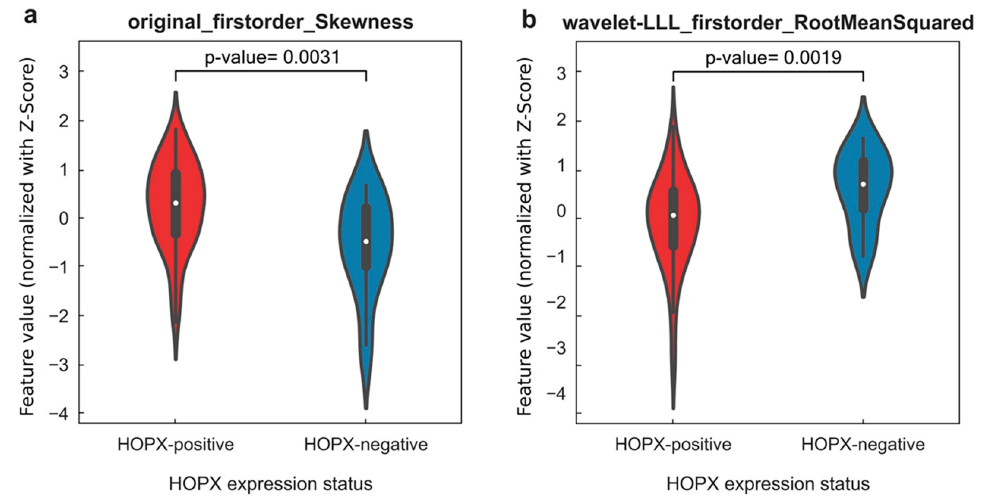
Figure 7. ( a ) Violin plot of image feature “original_firstorder_Skewness” of all HOPX-positive and HOPX-negative patients, which showed a significant difference in data distribution ( p = 0.0031); ( b ) violin plot of image feature “wavelet-LLL_firstorder_RootMeanSquared” of all HOPX-positive and HOPX-negative patients, which showed a statistically significant difference in data distribution ( p = 0.0019).